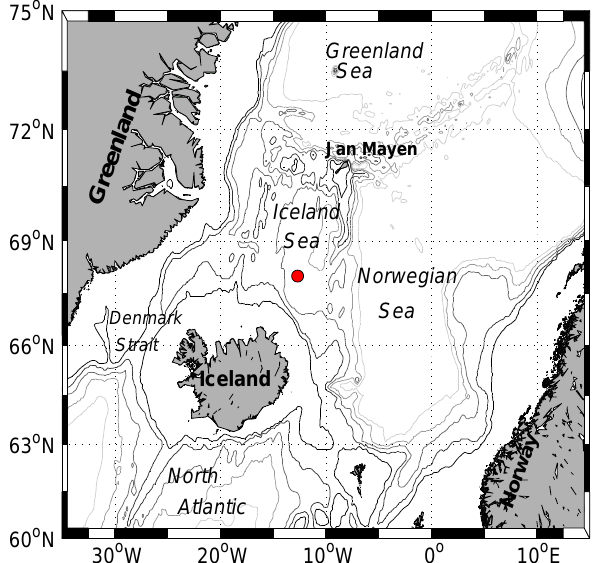
Figure 1. Map of the Nordic Seas region. The red filled circle marks the position of the time series